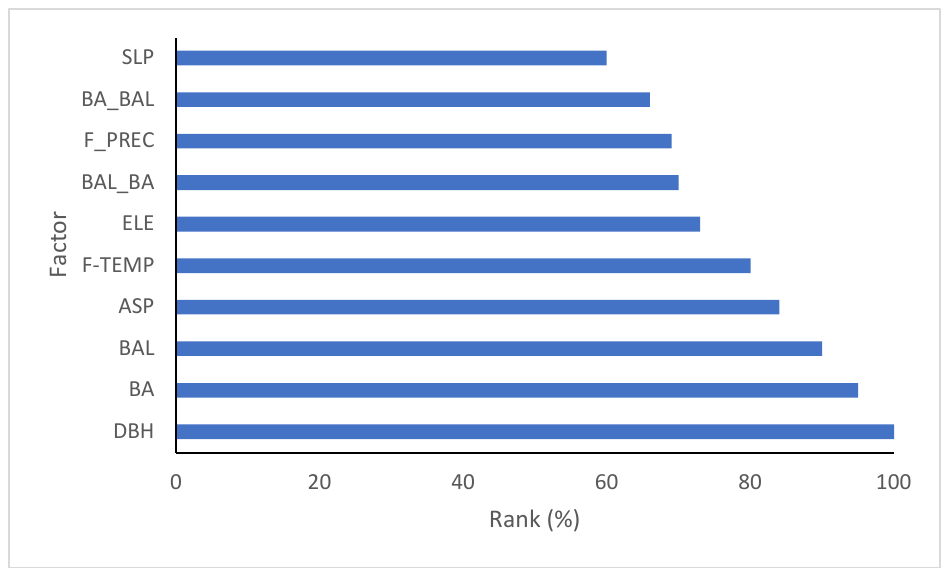
Figure 12. Relative importance of predictor factors in the ANN model for future diameter increment. SLP is slope, BA is basal area, BAL is basal area in largest trees, PREC is participation, DBH is diameter at breast height, TEMP is temperature, ASP is aspect, and ELE is elevation, Table 11 shows the diameter increment changes from the current to 2070 under cli- mate change. The results show that due to changes in precipitation and temperature in the region, the amount of diameter increment model is decreasing in the forest region. Table 11. Changes in individual diameter increment (cm) by regression and artificial neuron net- work under climate change. Climate Condition